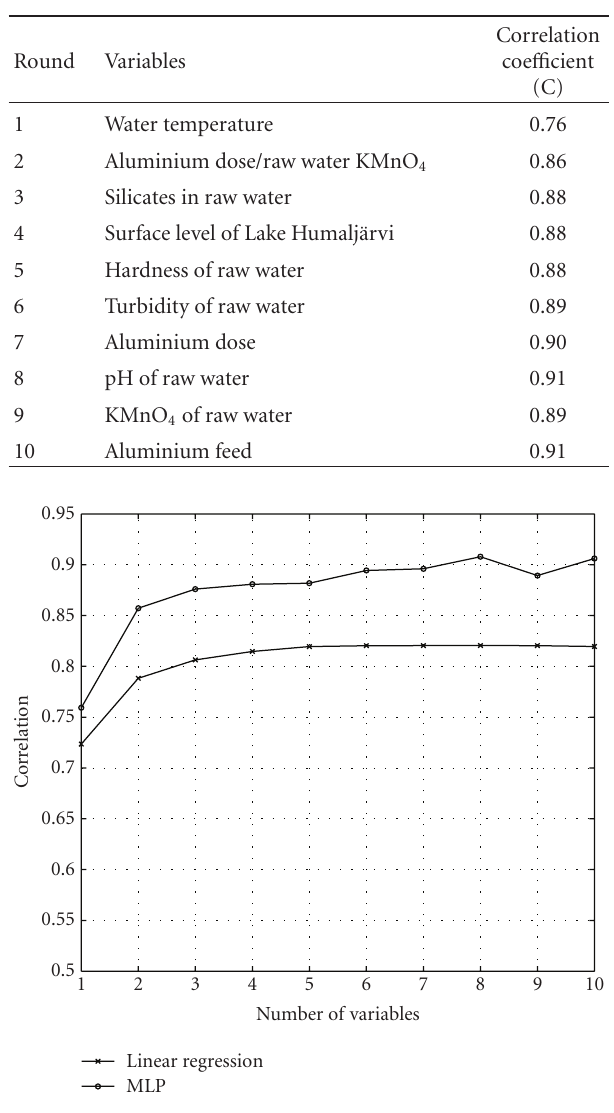
Figure 5: Evolution curves for residual aluminium. The goodness of the model improves at first as variables are added, and then the improvement gradually